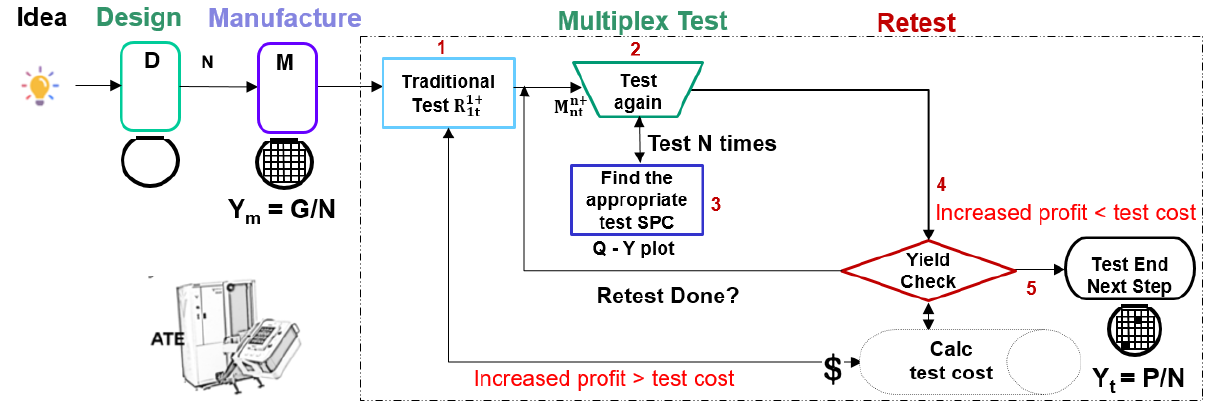
Figure 11. Flow chart of enhanced IC test system (RTS).